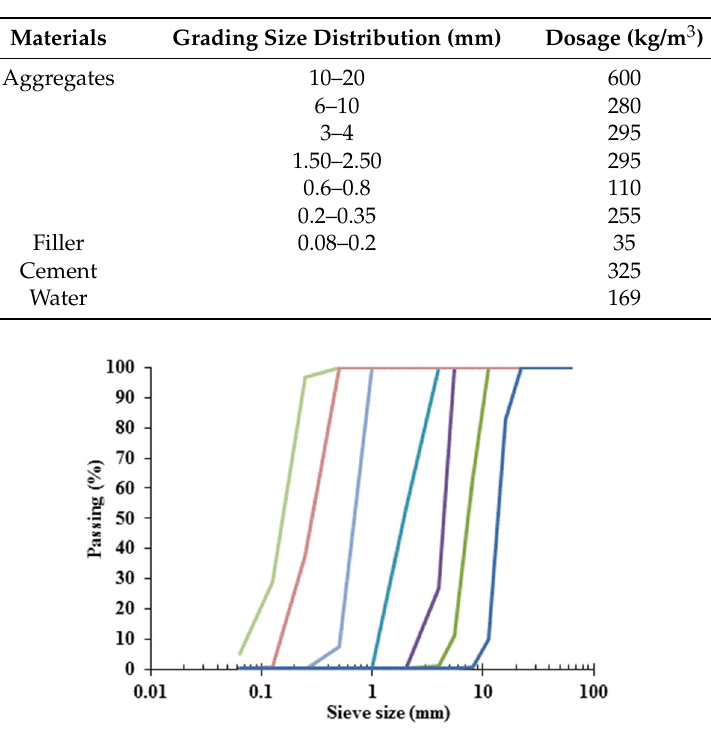
Figure 1. Particle size distribution.